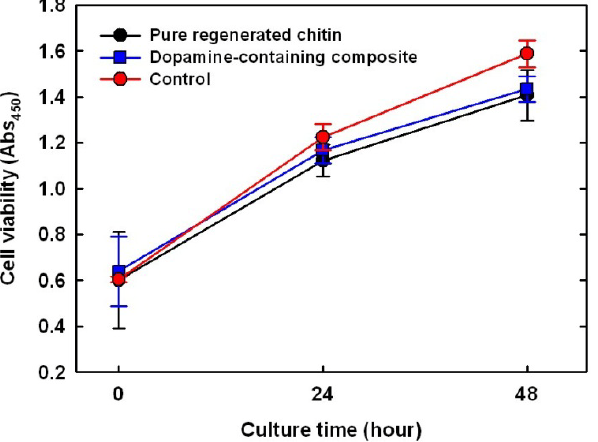
Figure 5. Comparison of MC3T3 cell proliferation on pure regenerated chitin (black); 10 wt % dopamine-containing composite (blue); and negative control (red, culture